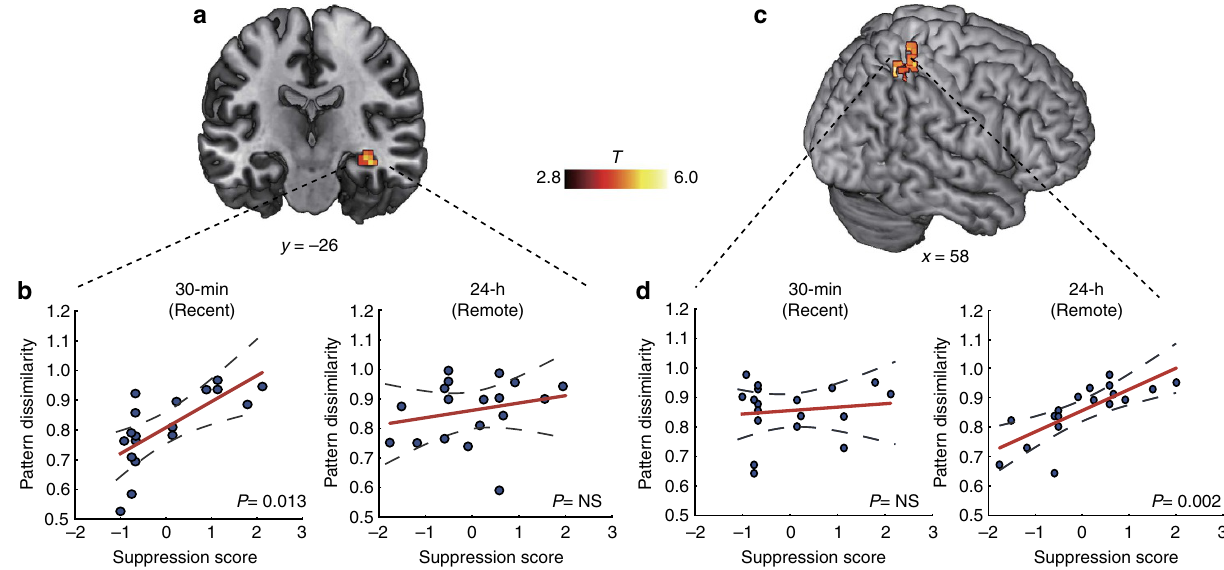
Figure 6 | Distinct multivoxel representational patterns following consolidation. ( a , b ) Pattern dissimilarity in the hippocampus was positively associated with more effective suppression of newly acquired aversive memories, but not after overnight consolidation. ( c , d ) Pattern dissimilarity in the lateral parietal cortex was positively associated with more effective suppression of aversive memories after overnight consolidation, but not in the newly acquired condition. Dotted lines indicate 95% confidence intervals and red solid lines indicate the best linear fit. MNI, Montreal Neurological Institute coordinate